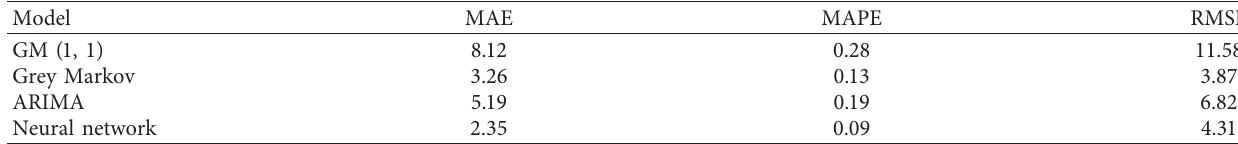
Figure 5: Comparison of measured and predicted dust concentration. Table 7: Comparison of prediction accuracy of the above models.